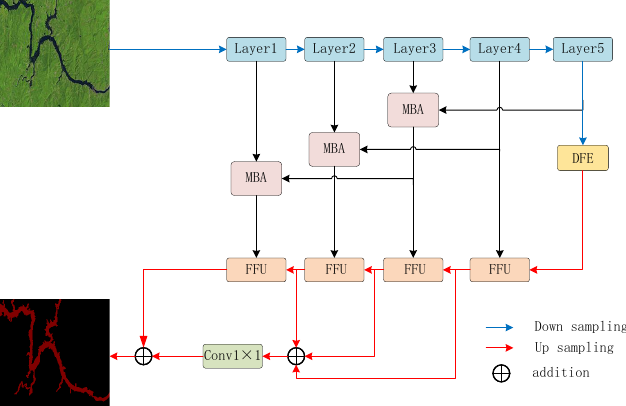
Figure 1. Multi-scale Feature Aggregation network. The ResNet-50 is used to extract features of different levels. The deep feature extraction module (DFE) can obtain multi-scale features and pay attention to global and local edge information. The multi-branch aggregation module (MBA) is used to enhance the interconnection and integrate the two types of feature representation, and the feature fusion upsample module (FFU) is used to complete feature fusion and location